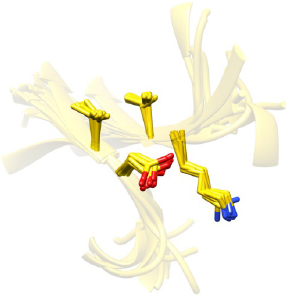
Figure 10. An RSM with identical side chain packing. The 2 + 2 RSM with the highest level of recurrence is shown. It is found in 15 mutually unrelated chains. The side chain of the Asp seems to hydrogen bond to the main chain of the Lys in the other